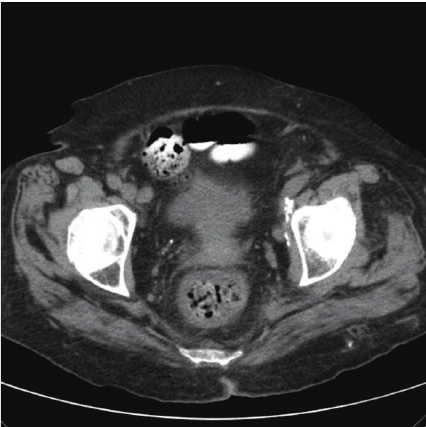
Figure 1: Edema of the